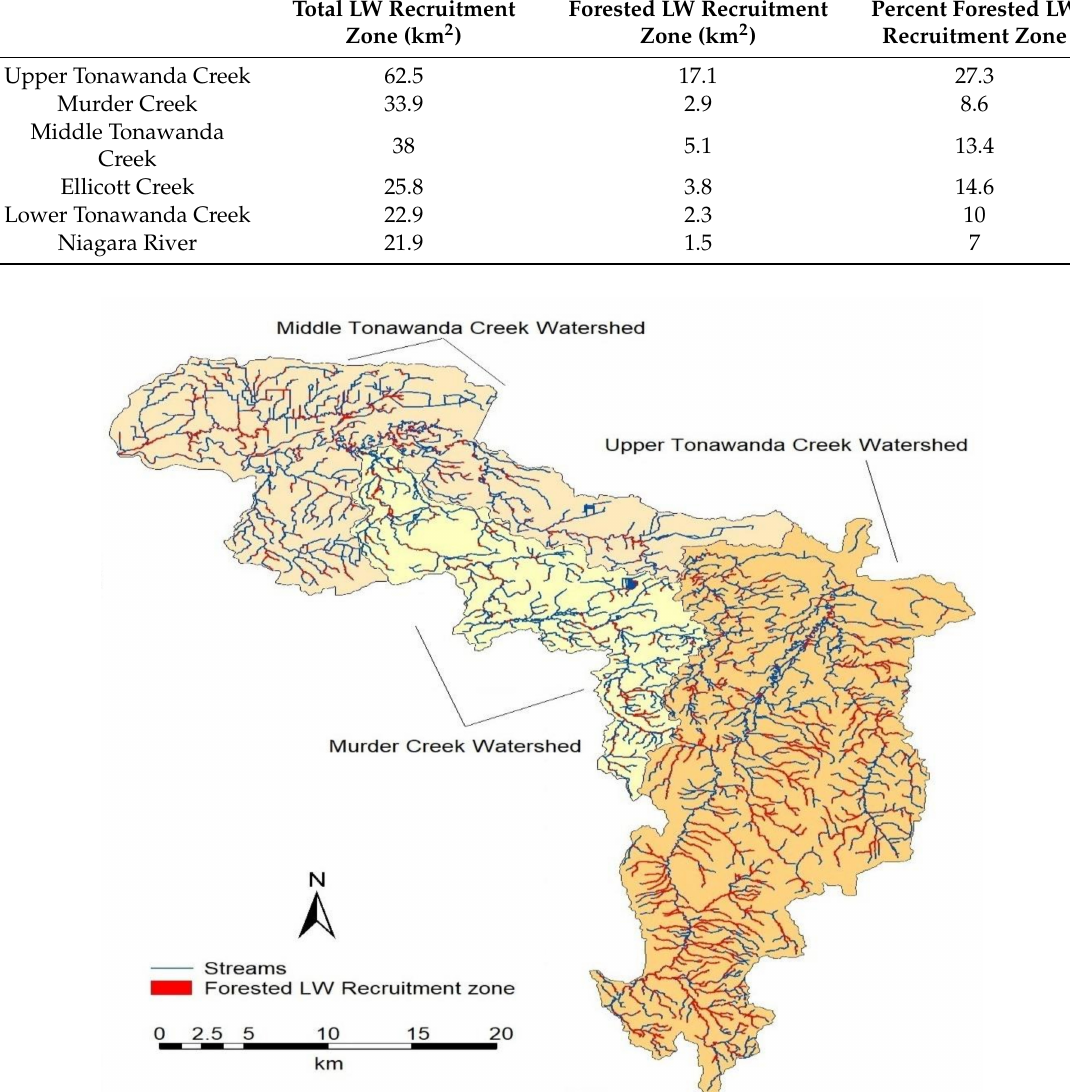
Figure 3. Map illustrating forested large wood (LW) recruitment zones in the Middle Tonawanda Creek, Murder Creek, and Upper Tonawanda Creek